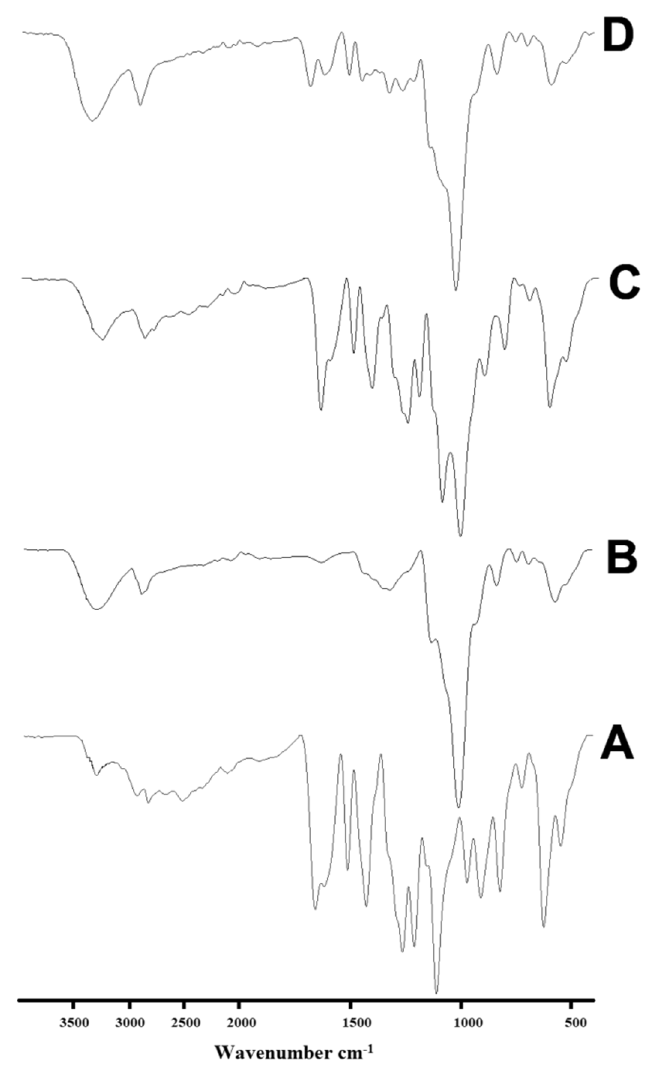
Figure 5. FTIR spectra of ( A ) SA, ( B ) HPβCD, ( C ) BPM, and ( D ) BIC.